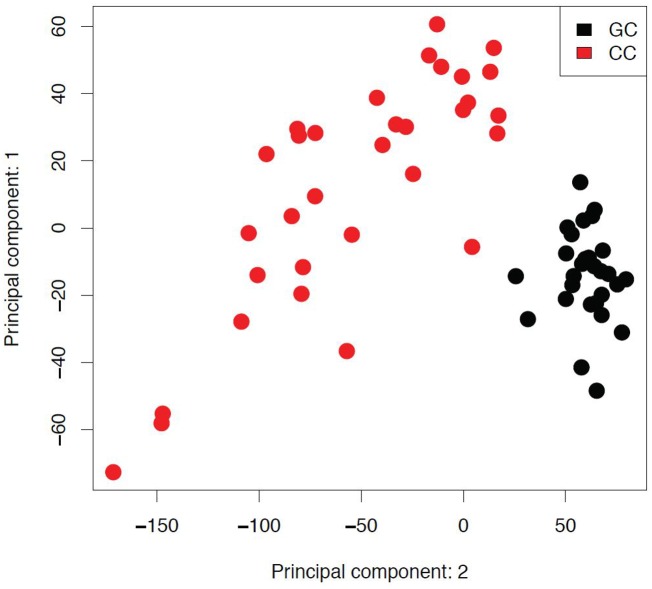
Principal component analysis between granulosa and cumulus cells.The axes of the plot represent first two main components of variance, obtained by performing principal component analysis (PCA) on global expression profiles. GC- granulosa cells; CC- cumulus cells.